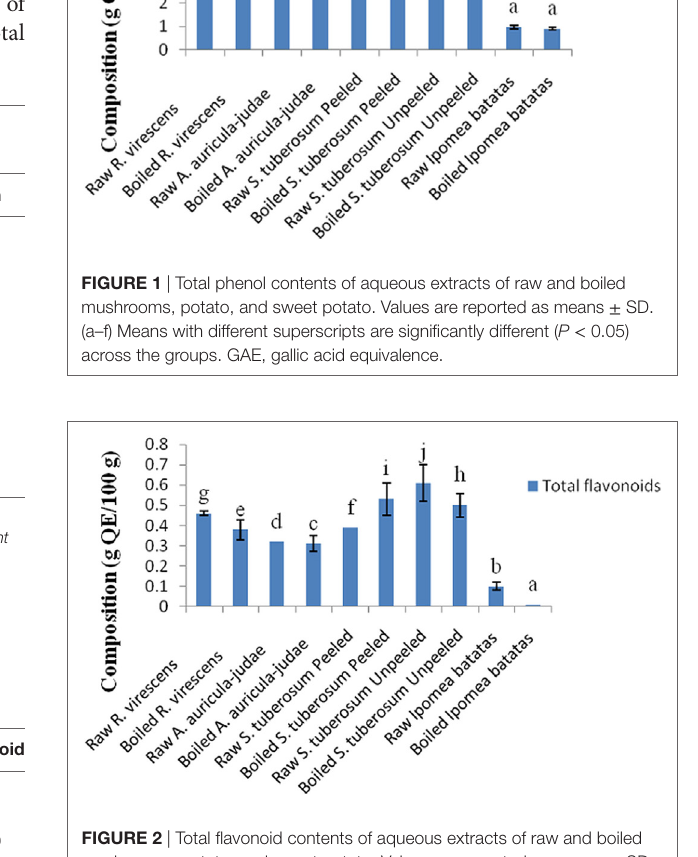
FigUre 2 | Total flavonoid contents of aqueous extracts of raw and boiled mushrooms, potato, and sweet potato. Values are reported as means ± SD. (a–j) Means with different superscripts are significantly different ( P < 0.05) across the groups. QE, quercetin